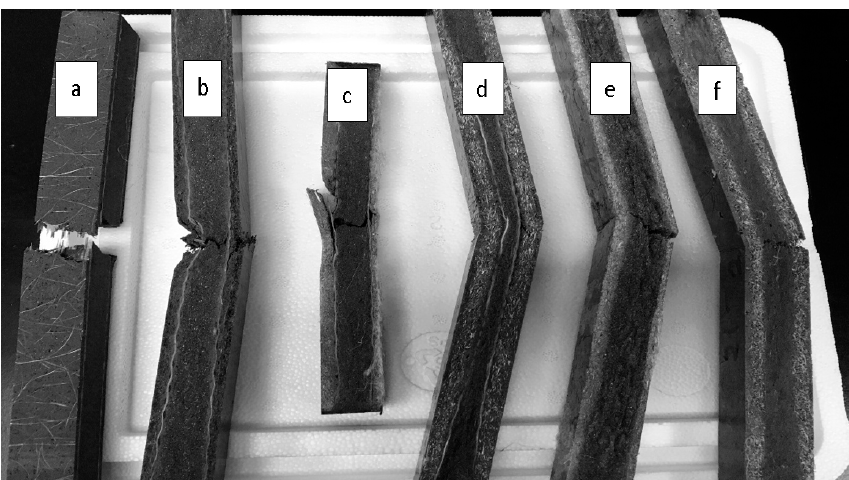
Figure 8. Images of composite samples tested for flexural properties showing the failure surface. ( a ) commercial glass (G’G); ( b ) glass (GG); ( c ) hybrid flax and glass (FG); ( d ) hybrid hemp and glass